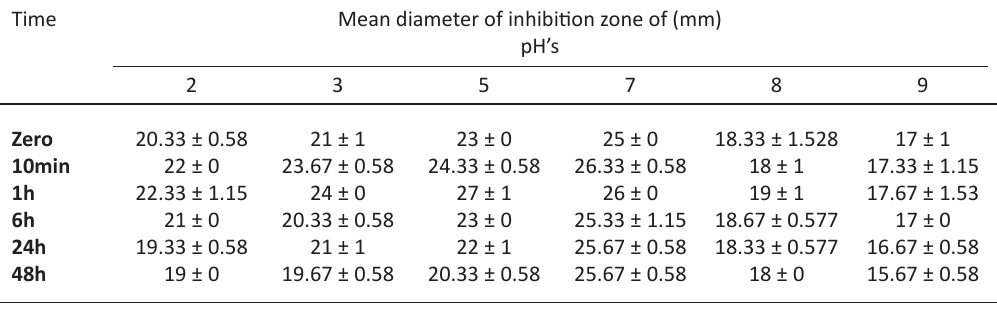
Table 6. Antimicrobial activity of the mixture of ethyl acetate extract of P.plebeium, PP and E hirta, EH against MRSA, B39 in relation to different pH’s Time